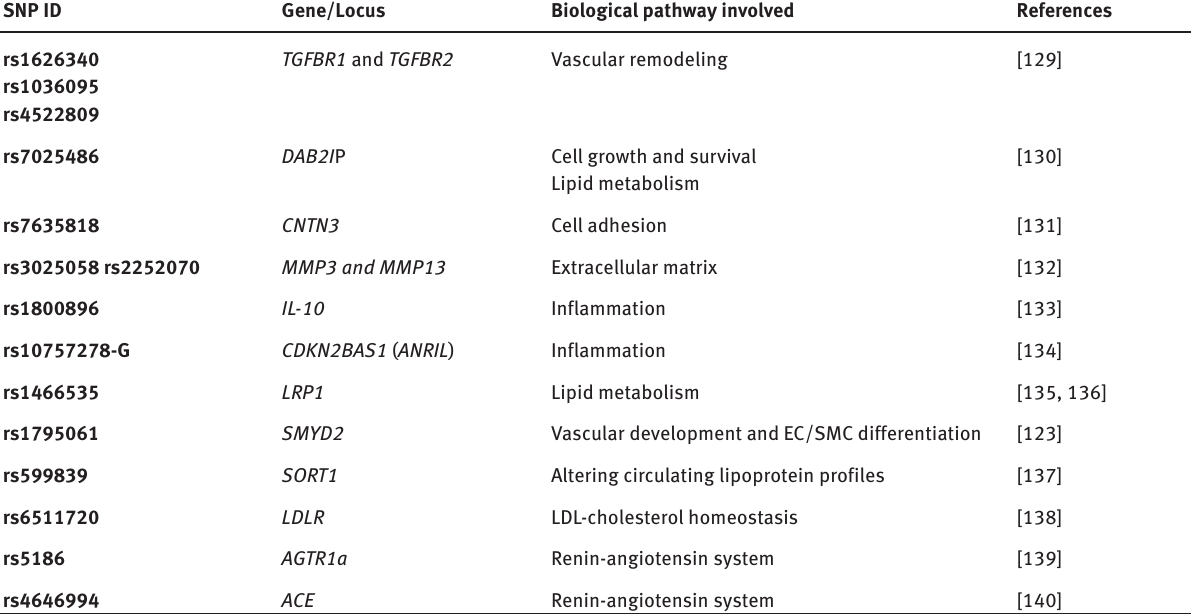
Table 1 : The summary of several SNPs and their respective genes studied for conferring susceptibility to AAA. SNP